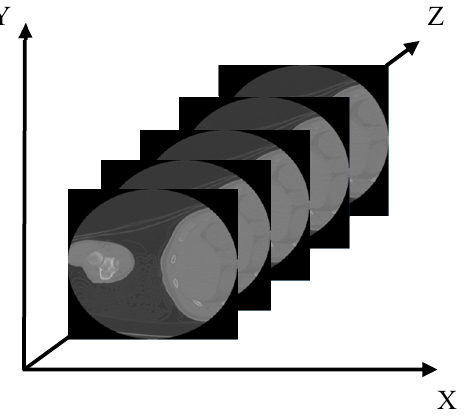
Figure 1. Acquired axial computed tomography (CT) images